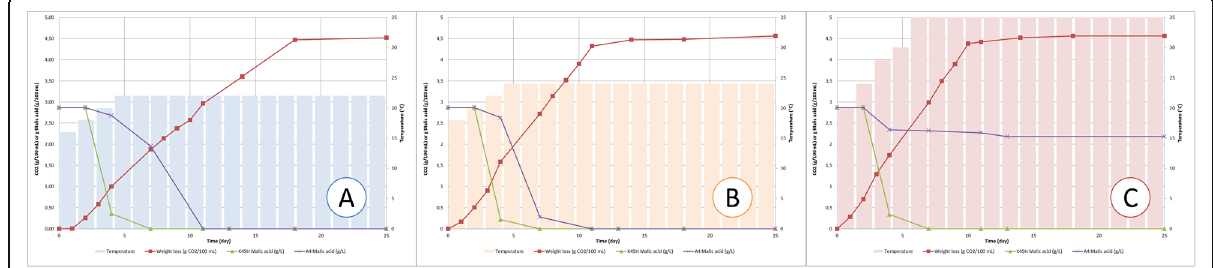
Fig. 2 Evolution of alcoholic and malolactic fermentation in function of different temperature profiles in grape must of cv. Chardonnay harvested in full maturity (mean data, n = 6 for AF and 3 for MLFs). a T1 test: 16/22 °C in 3 days, b T2 test: 18/24 °C in 3 days, and c T3 test: 22/32 °C in 5 days. The highest temperature profile interfered by the accomplishment of the AF, independently from the LAB strains, and with the MLF performed by the O. oeni A4